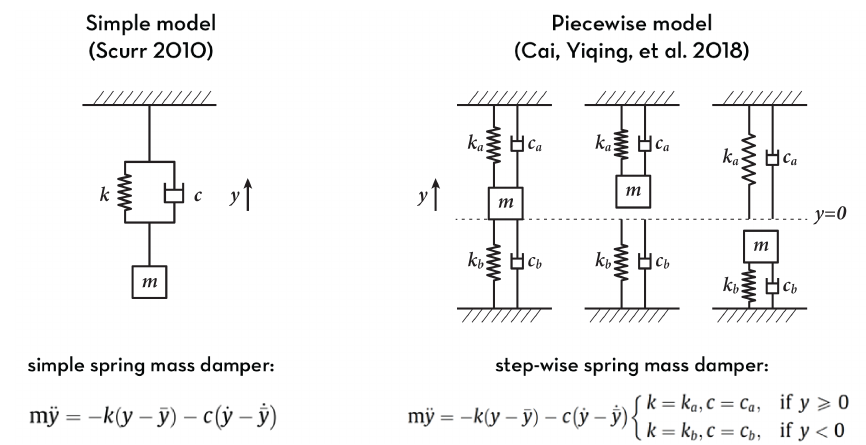
Figure 4. Diagrams of two precedent spring mass damper breast